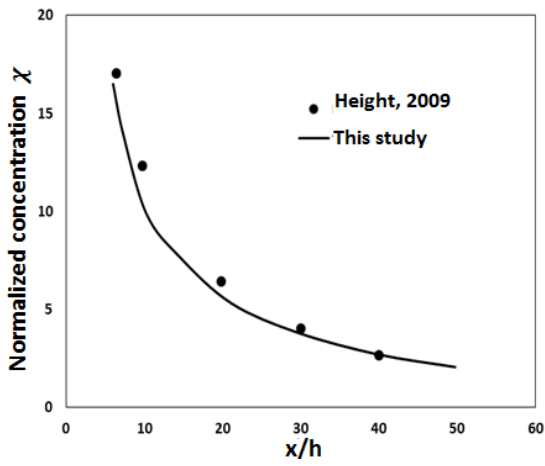
Figure 5. Comparison of normalized concentration.